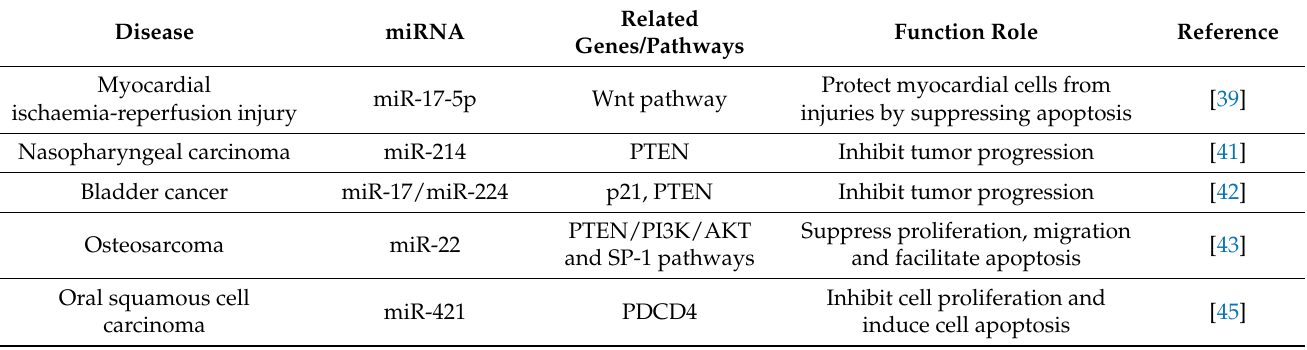
Table 1. Target and role of circ-ITCH in cell apoptosis/cell cycle.